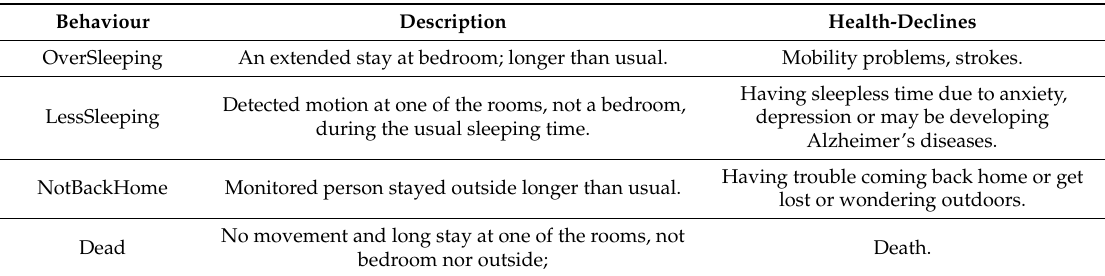
Table 2. Abnormal Behaviours—Descriptions and related